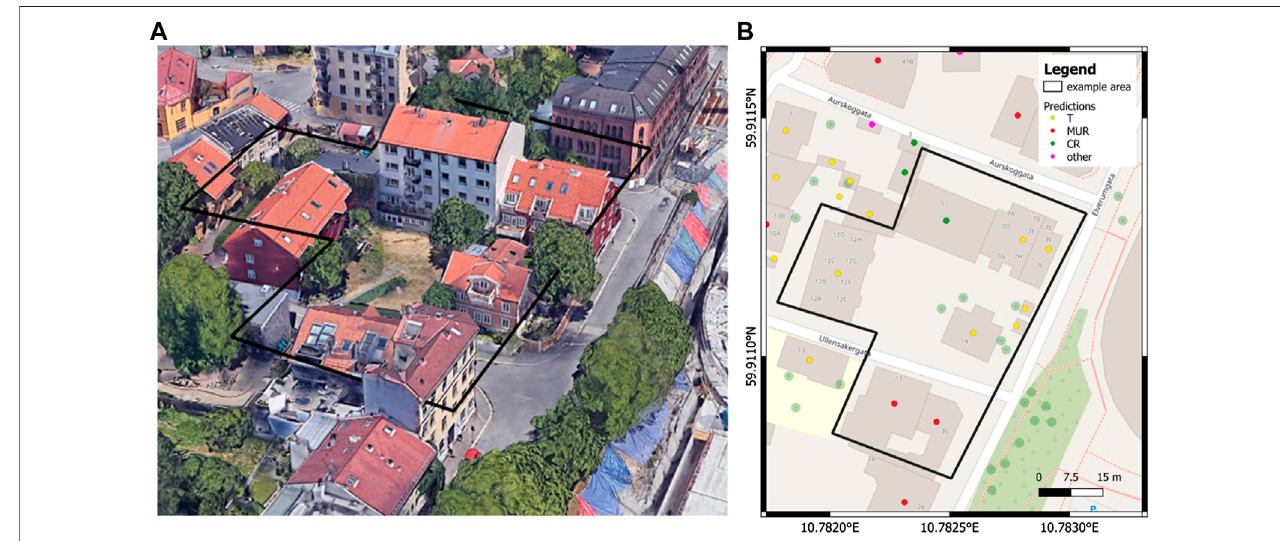
FIGURE7|(A) :GoogleEarth3Dbuilding ’ sviewoftheexampleareainOslo; (B) ,thepredictedMBTforthesameexamplearea.TheobservedandtrueMBTforthe selected area coincides with the predicted one.